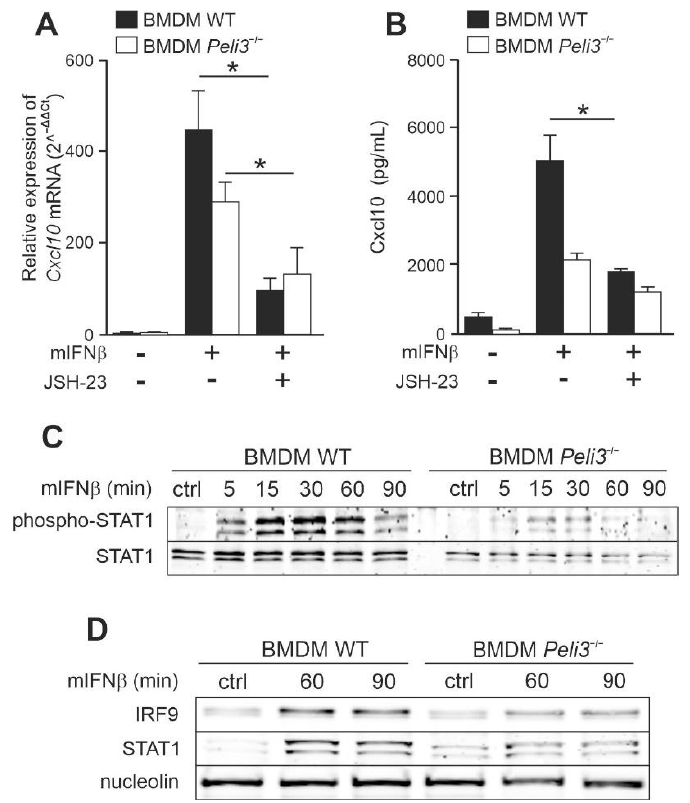
Figure 6. Pellino3 promotes mIFN β -induced production Cxcl10 via IRF9-dependent pathway in BMDM cell line. Wild type (WT) and Peli3 −/− BMDM cells were pretreated with DMSO ( −/− ) or